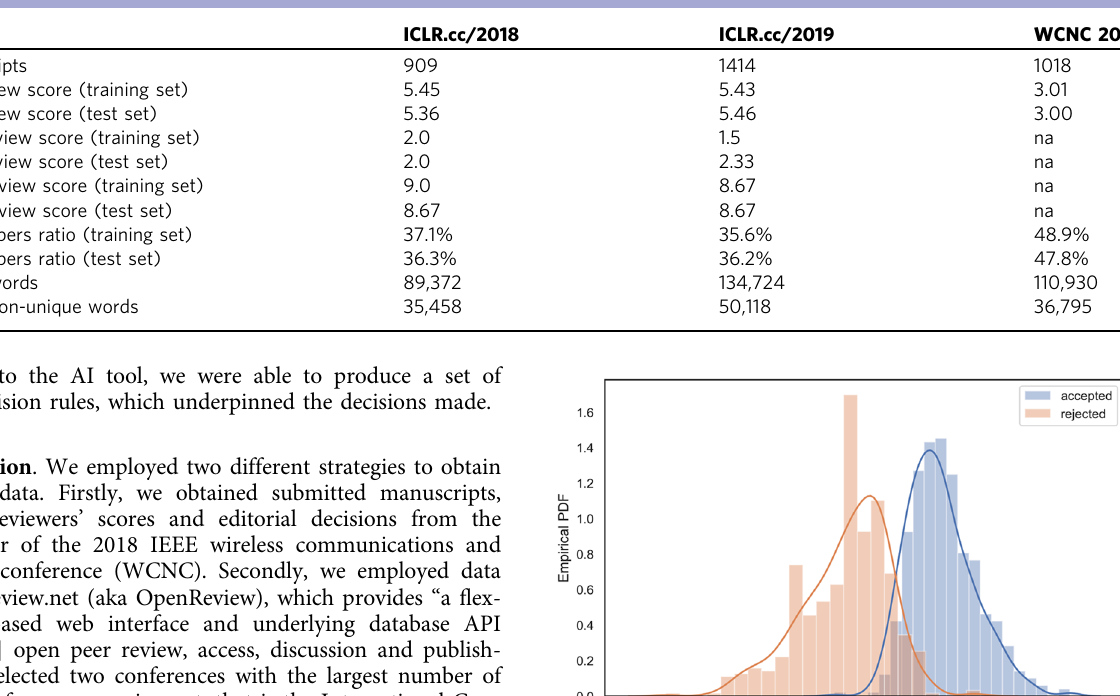
Table 1 Collected datasets summary. For WCNC only the average score is available.